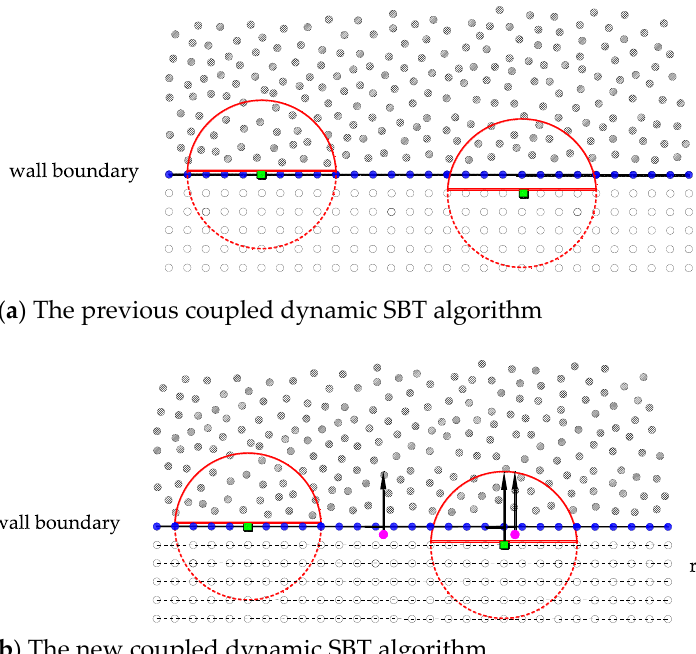
Figure 1. Illustration of ( a ) the previous coupled dynamic SBT algorithm and ( b ) the new coupled dynamic SBT algorithm (the black solid line denote the wall boundary; the red node is the fluid particle; the green square represent the boundary particle of concern; the split red circle represent the support domain of the boundary particle, and the physical quantities of particles in the solid part are used to calculate the boundary particle’s physical quantities, details shown in references [16,23,24]. Figure 1a is from references [16,23,24].)